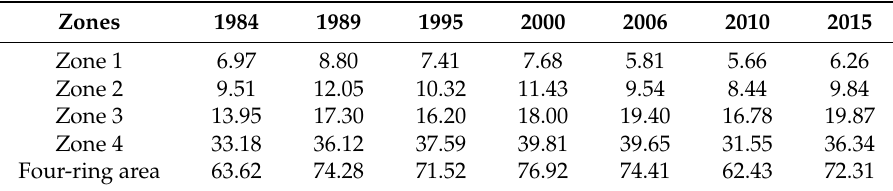
Table 4. Runoff volume in different regions from 1984 to 2015 (10 6 m 3 ).